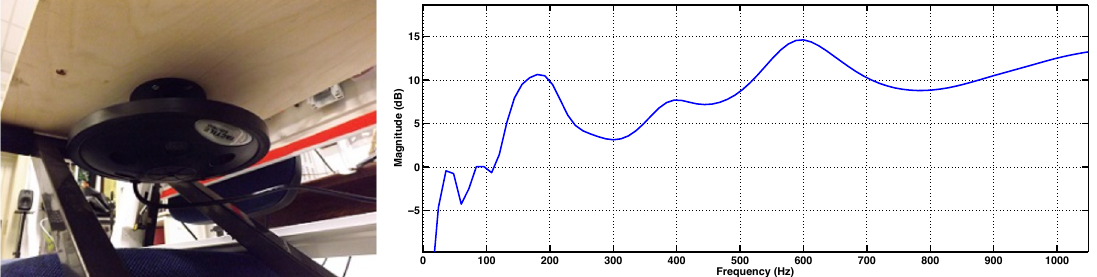
Figure 6. Left : tactile transducer mounted below the haptic digital piano keybed. Right : average spectral flattening curve. Pictures from